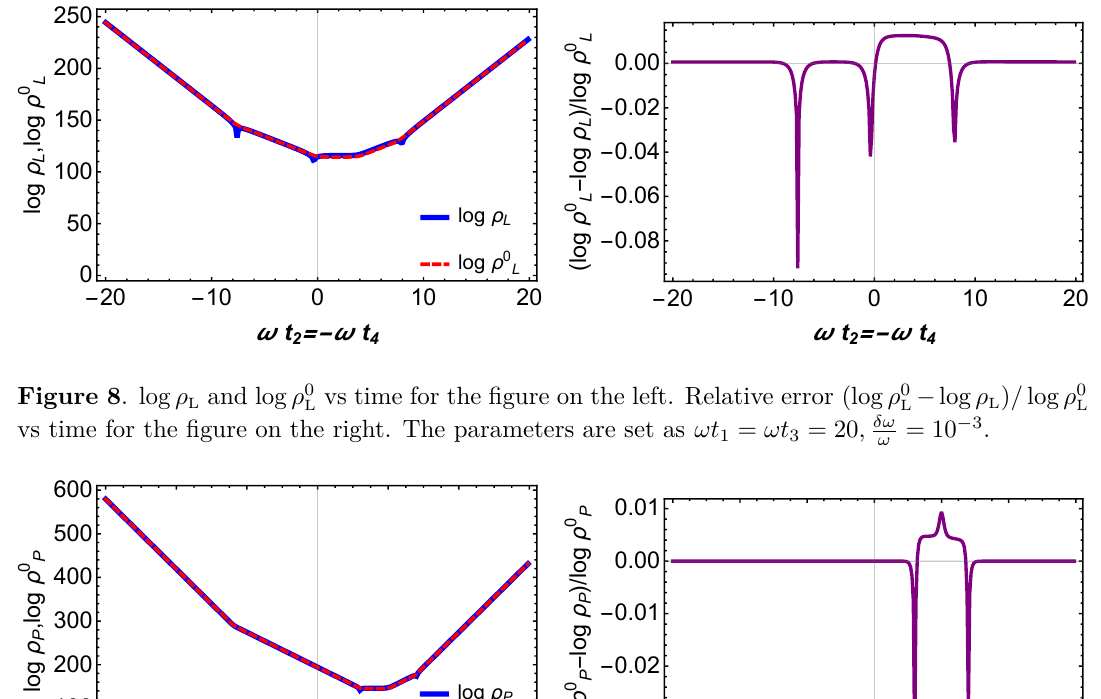
− log ρ ) / log ρ 0 P P P